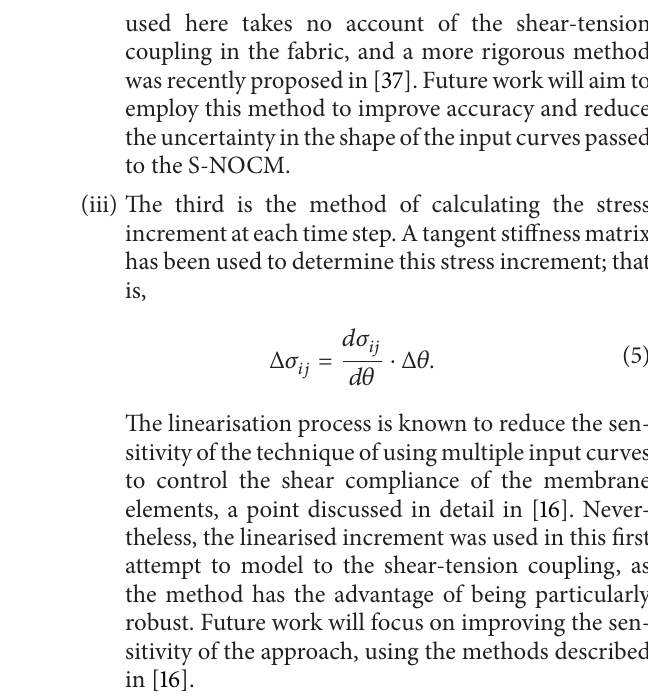
Figure 6: Comparison between the experimental and the predicted results using the coupled S-NOCM and normalized 𝐹 𝑠 − 𝜃 input curves from the BBE 3 :1